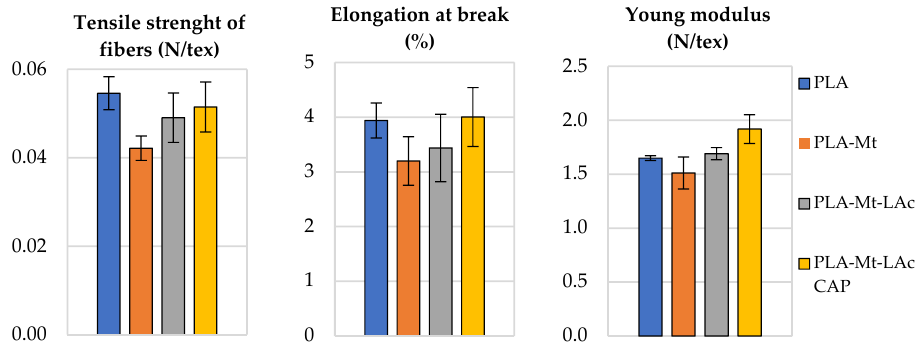
Figure 5. Tensile strength of fibers, elongation at break, Young modulus for PLA, PLA-Mt, PLA-Mt- LAc and PLA-Mt-LAc-CAP.